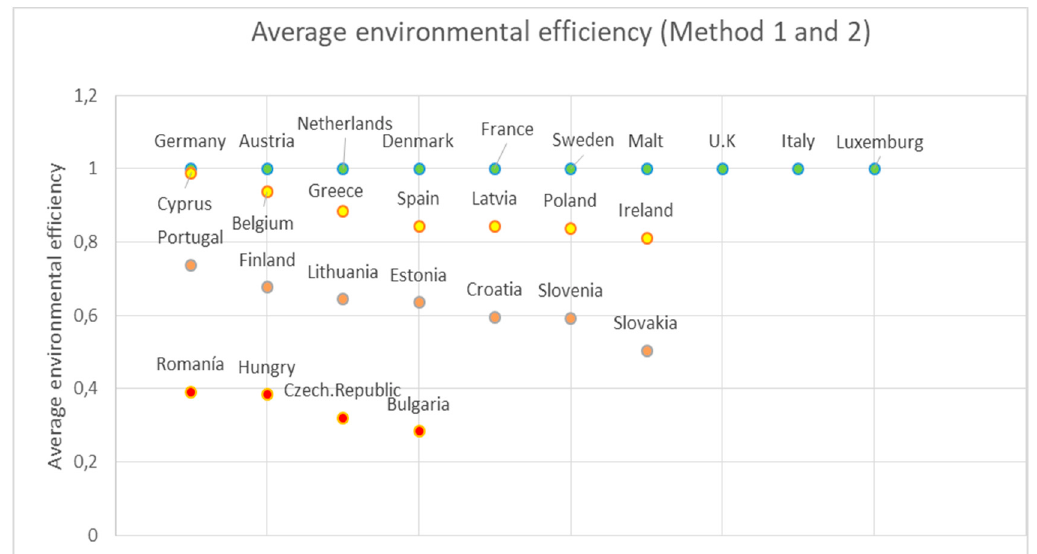
Figure 10. Values of average environmental efficiency obtained from the average environmental efficiency data of Method 1 and average environmental efficiency of Method 2. Source: own